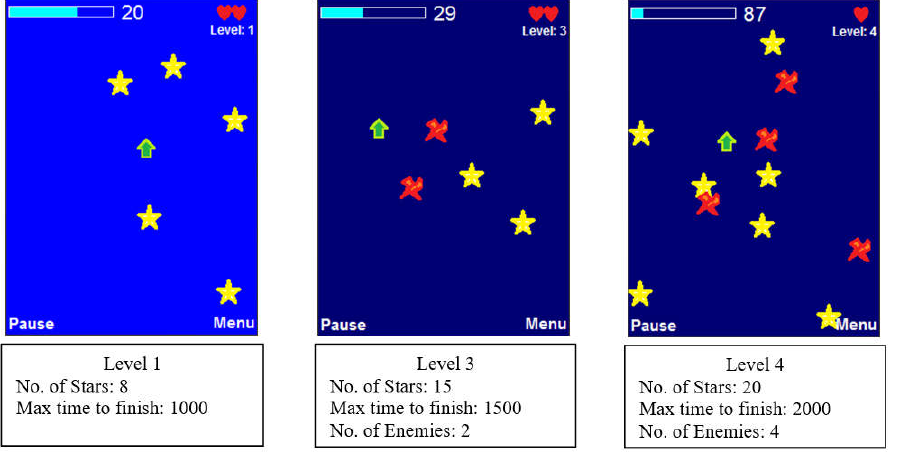
Figure 22. Related levels of GrabStar demo